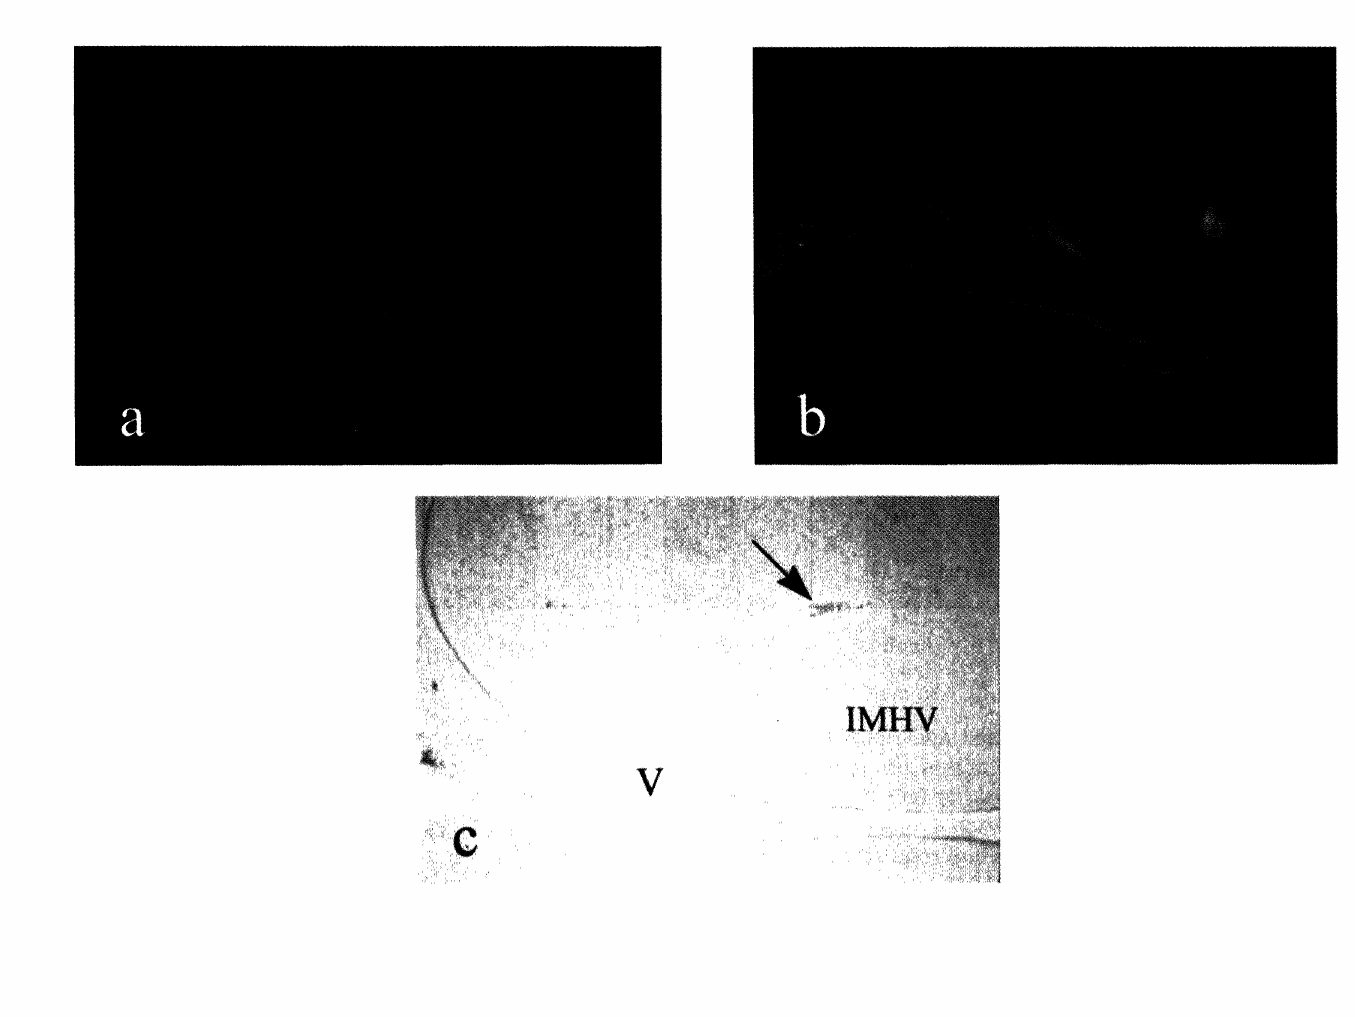
Fig. 3: Immunocytochemistry of anti-ApoE and anti-Apo-A-I localization 30 min post- injection. One-day old chicks were injected bilaterally into the IMHV with anti-ApoE (a) and anti-ApoA-I (b). Thirty min later chicks were killed, brain tissue frozen and immunocytochemistry carried out on 15 Im coronal sections as described in the Experimental section. Texas Red conjugated anti-mouse IgG was used to locate the injected anti-ApoE and Fluorescein-conjugated anti-rabbit IgG to locate the anti-ApoA. Sections (a-b) were examined on a Leica confocal microscope (xl00). Toluidine blue counterstained sections (c) were examined on a Zeiss Axiophot (25). Sections a-b show the remaining fluorescence in ventricles; c: Toluidine blue counterstaining, the arrow indicates the injection site. V- ventricle, IMHV- intermediate medial hyperstriatum